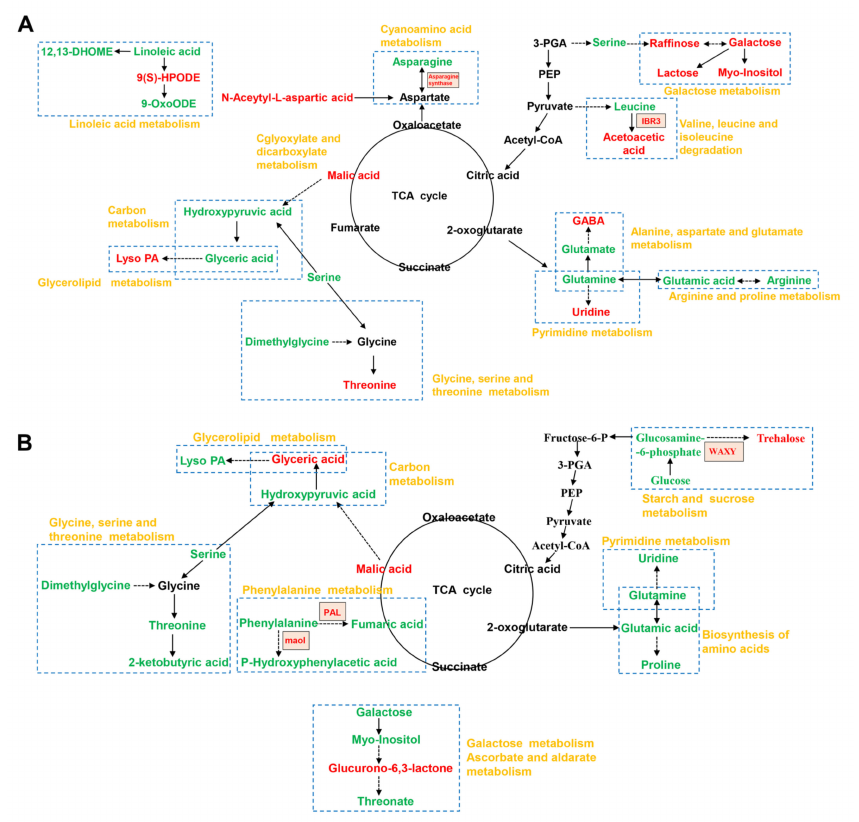
Figure 9. The network of key DAMs in GN2 ( A ) and GN18 ( B ) seeds induced under salt stress in metabolism. The upregulated and downregulated metabolites are indicated in red and green colors, respectively. The metabolic pathway is circled with a blue dotted border, and the name of the metabolic pathway is written in yellow font. The dotted arrows indicate multiple steps between the two